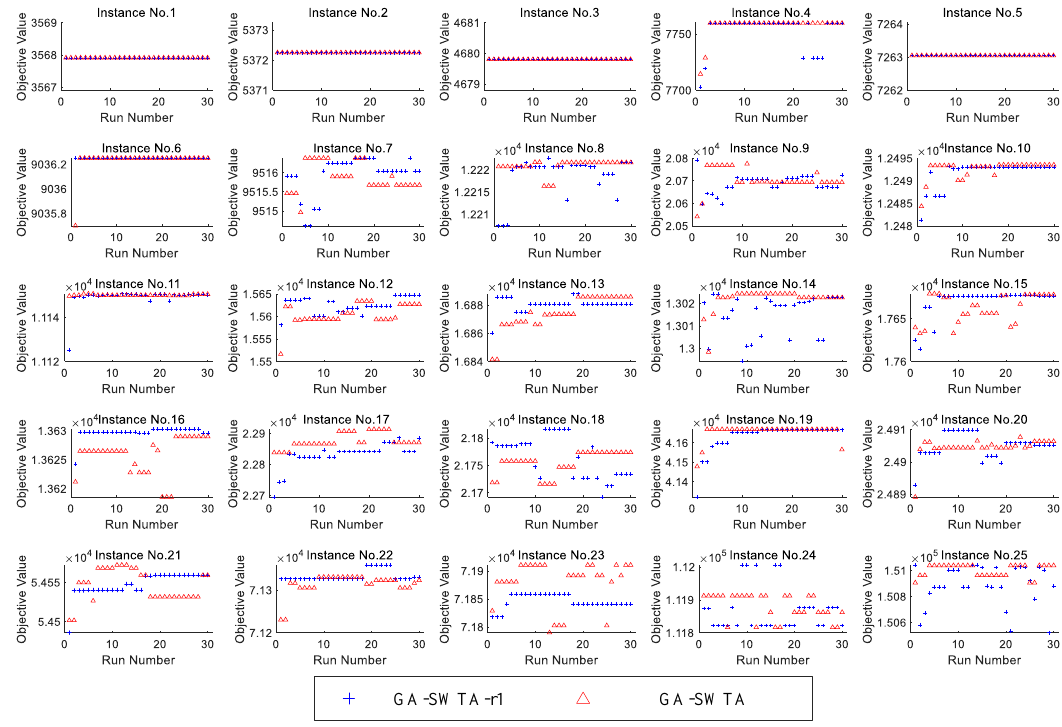
Figure 12. Comparison results of GA-SWTA-r1 and GA-SWTA with respect to the objective